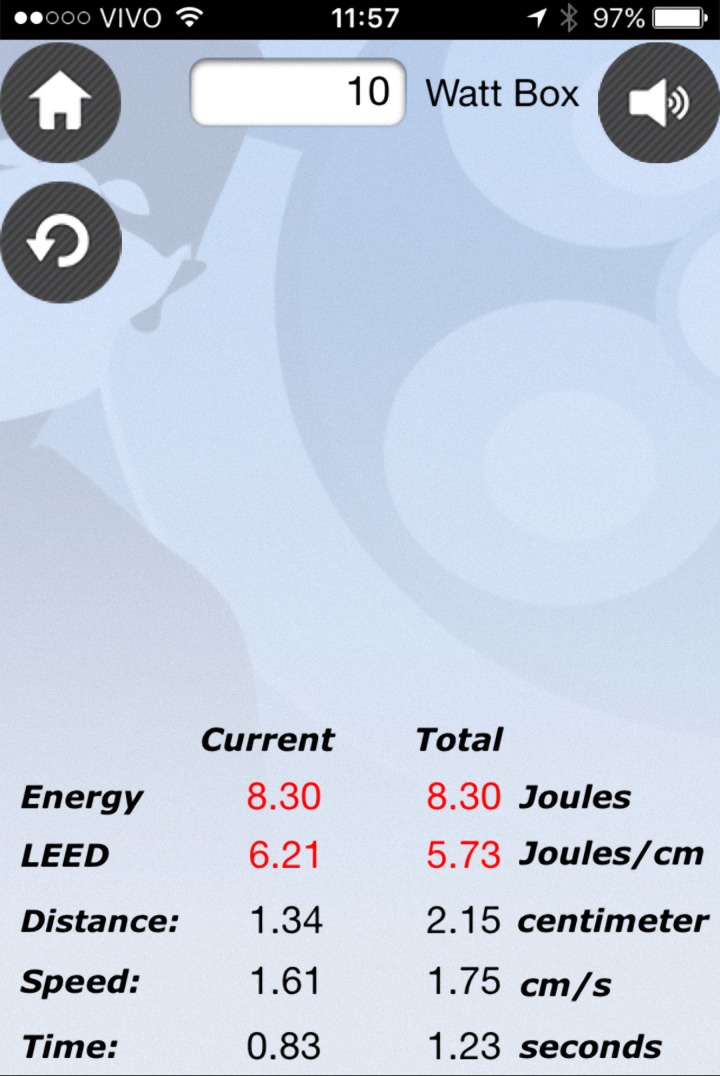
Main window of the EVLTraining® app showing the variables controlled. The same screen is responsible for measurement by touch.